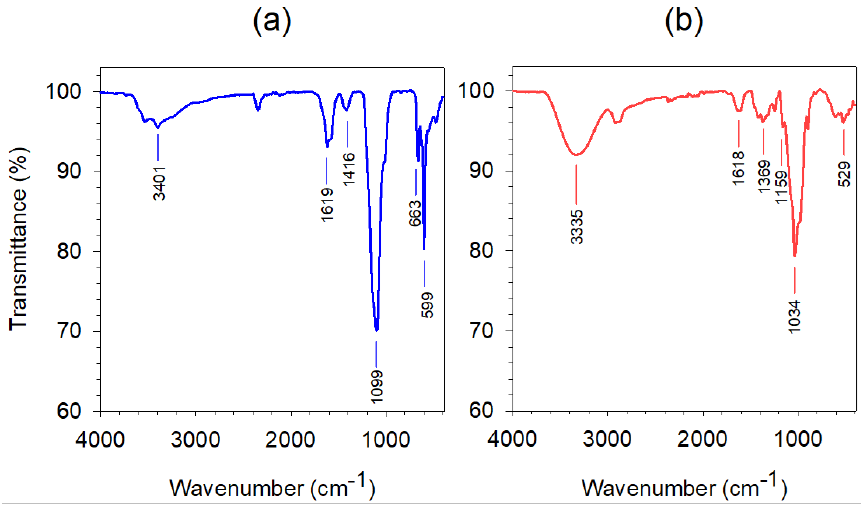
Figure 2. FTIR footprints of ( a ) L-PSPC (leaves) and ( b ) S-PCPC (seeds).